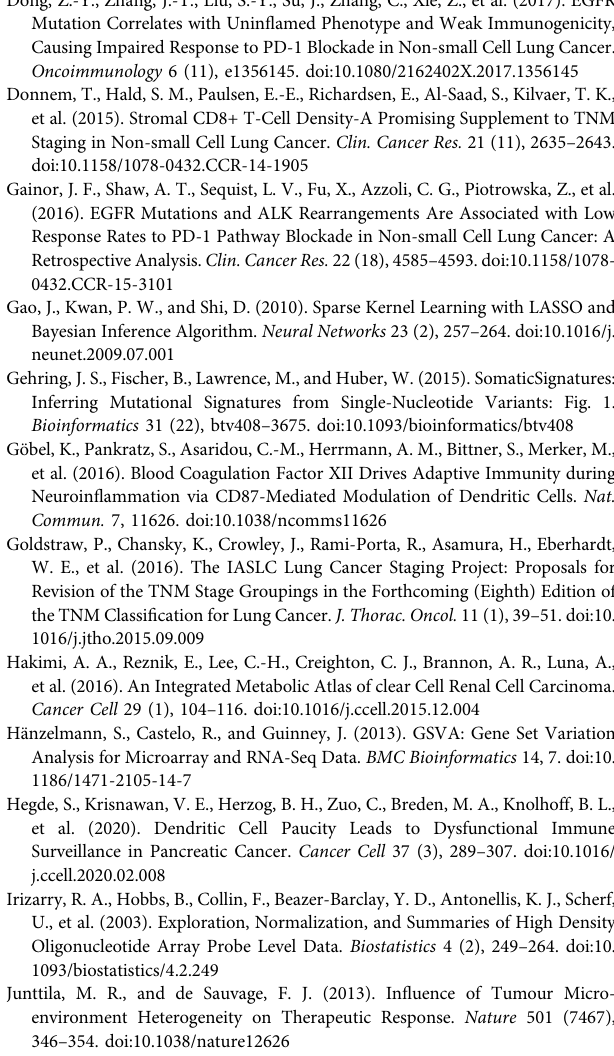
Contributions of point mutations of de novo mutation signatures (S1 − S11) in the training set. (D) Comparison of the contributions of de novo mutation signatures (S1 − S11) between the high- and low-risk groups SupplementaryFigureS8| Predictionoftheprognosticriskscore(PRS) modelfor immunotherapy bene fi ts of patients. (A) Comparisons of overall survival (OS) between the high- and low-risk patients in GSE135222. (B) Comparisons of PRSs of the responders and non-responders treated by immunotherapy in GSE126044. Supplementary Figure S9 | Analysis of PRSs, checkpoints, HLA-related genes, and enrichment pathways of NJDT patients. (A) Comparison of PRSs between normal and tumor samples of NJDT patients. (B) The expressions of checkpoints and HLA-related genes were compared between high- and low-risk patients. (C) GSEA (C2: curated gene sets, CP: KEGG) showed that the fi ve top pathways (antigen processing and presentation, cell adhesion molecules [CAMs], chemokine signaling pathway, cytokine receptor interaction, and natural killer cell-mediated cytotoxicity) were unregulated in the low-risk group. The symbol “ ns ” represents there is no signi fi cant difference between the two